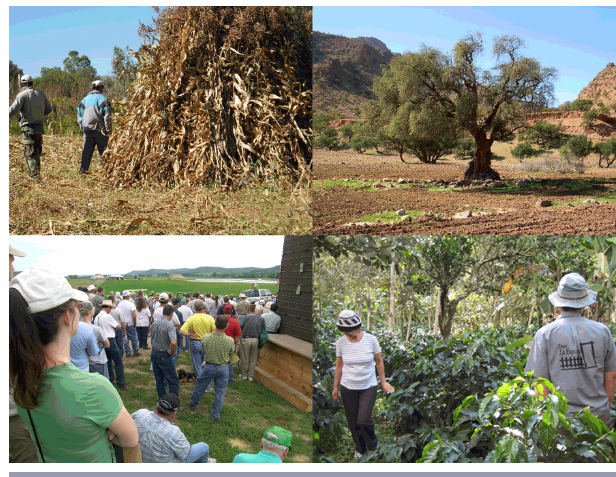
Fig. 3 . Agroecosystems and landscapes amid expanded smallholder telecoupling (clockwise from upper-left: cultivation of Andean maize among migrant households of telecoupled smallholders in Cochabamba, Bolivia; argan as high-value land use product in Morocco; coffee as eco-certified crop in agroforestry system in Santander, Colombia; small-scale organic dairy producers in Wisconsin, U.S. (photocredits: Karl Zimmerer, Ximena Rueda, Yann le Polain de Waroux,